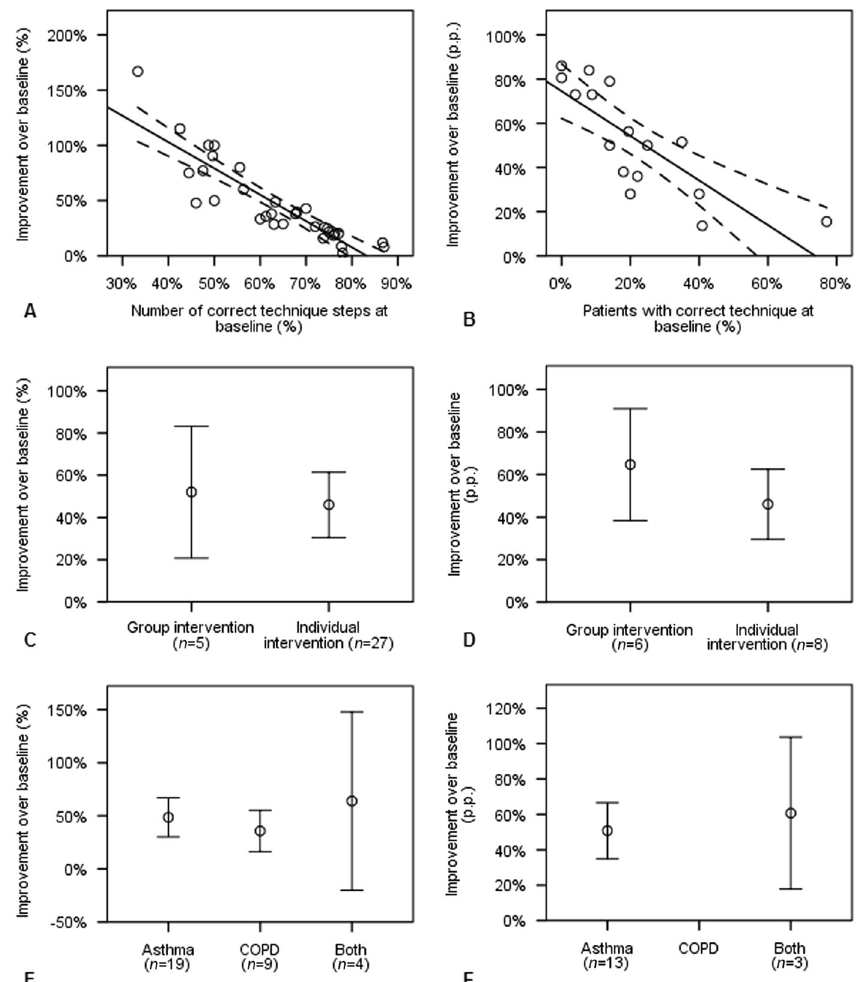
Fig. 3 Improvement in inhaler technique plotted against baseline performance ( a , b ), type of intervention ( c , d ), and patients ’ disease background ( e , f ) with 95% con fi dence intervals. The left column ( a , c , and e ) displays results for correct-steps studies, the right column shows results for correct-patients